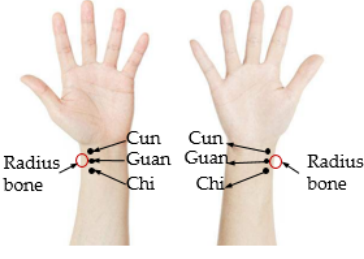
Figure 1. Regions of Cun, Guan and Chi.